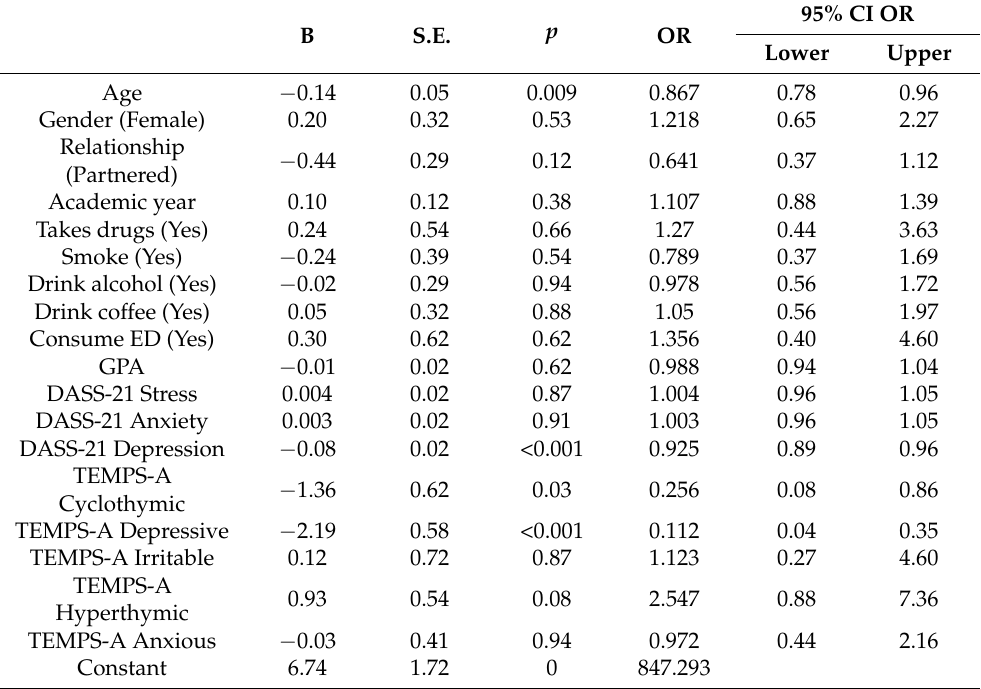
Table 5. Predictors of positive mental health in the study